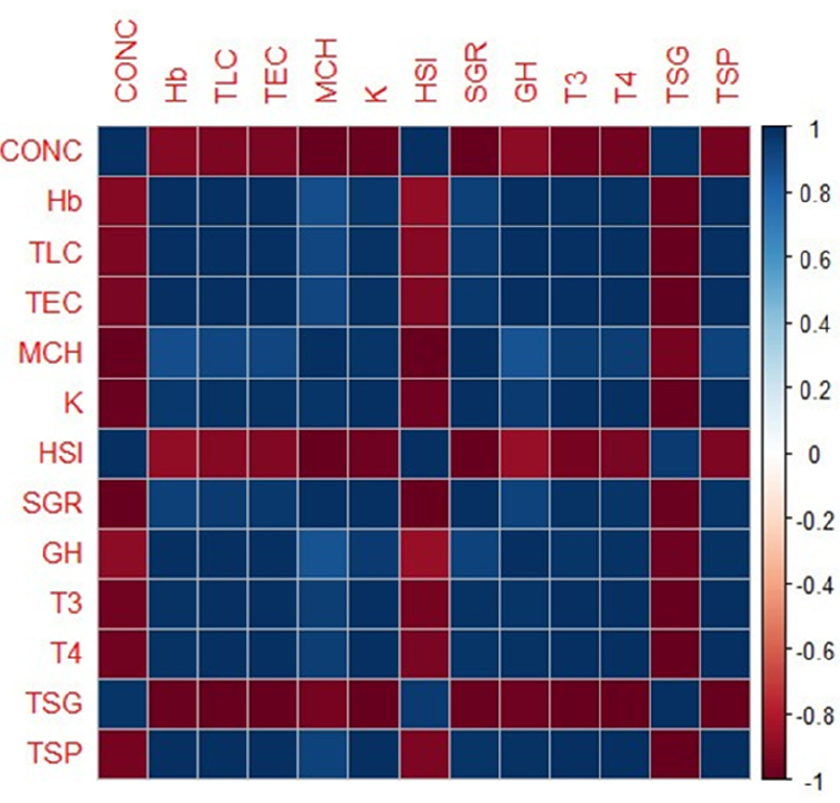
Figure 5. Correlogram of exposure concentration with hematological, biochemical, and growth parameters in Clarias batrachus .